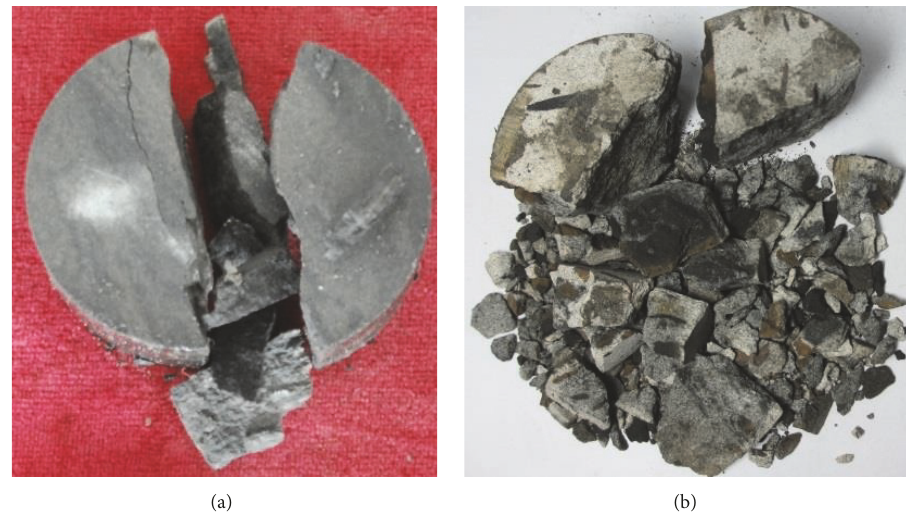
Figure 7: Dynamic Brazilian disc experiment specimen destruction: (a) normal temperature; (b) after 800 ∘ C heat treatment.